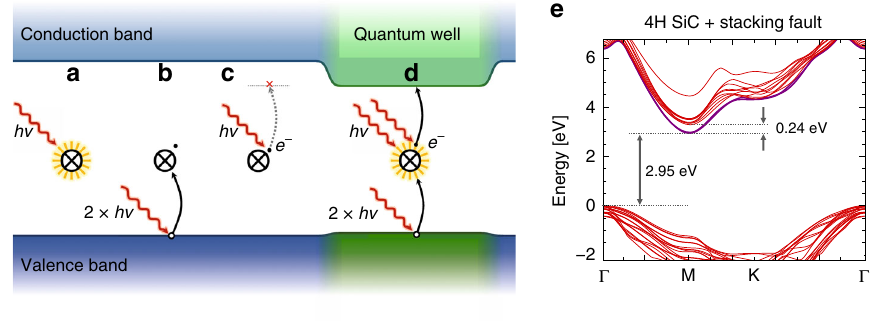
Fig. 1 A color center with a quantum well stabilized bright state. a A bright state of a color center under optical excitation. b These incident photons may ionize the defect and turn it into a dark state while also, c , does not have suf fi cient energy to repopulate the bright state. d In a quantum well, however, the excitation laser can successfully re-pump the bright state. e Band structure of a defective 4H-SiC including a stacking fault. Red curves depict bulk-like conduction and valence band states in the basal plane of the hexagonal Brillouin zone. Purple curves show the stacking fault states that localized in c direction and dispersive in the basal